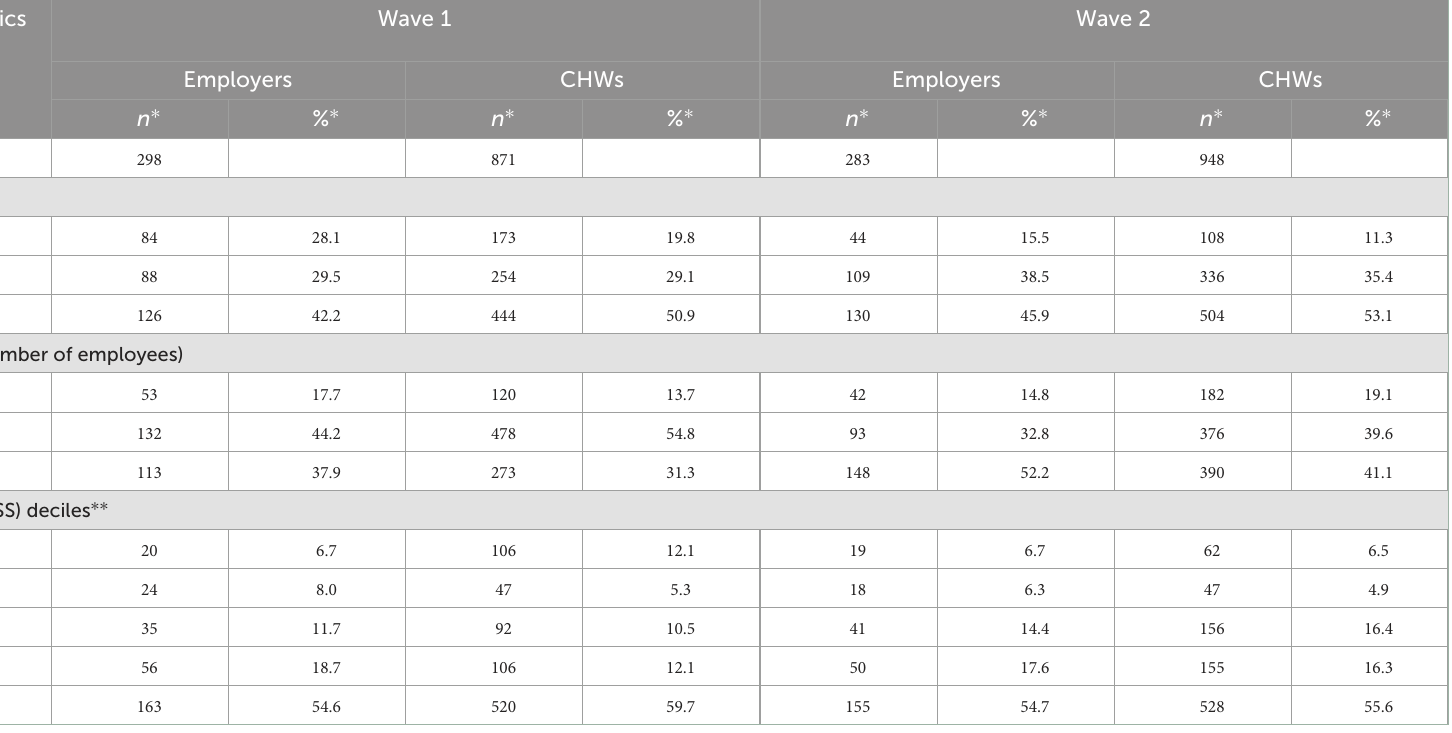
TABLE 1 Organizational characteristics of CHWs and CHW employers included in the sample frame. Organizational characteristics Wave 1 Wave 2 of the sample frame Employers CHWs Employers